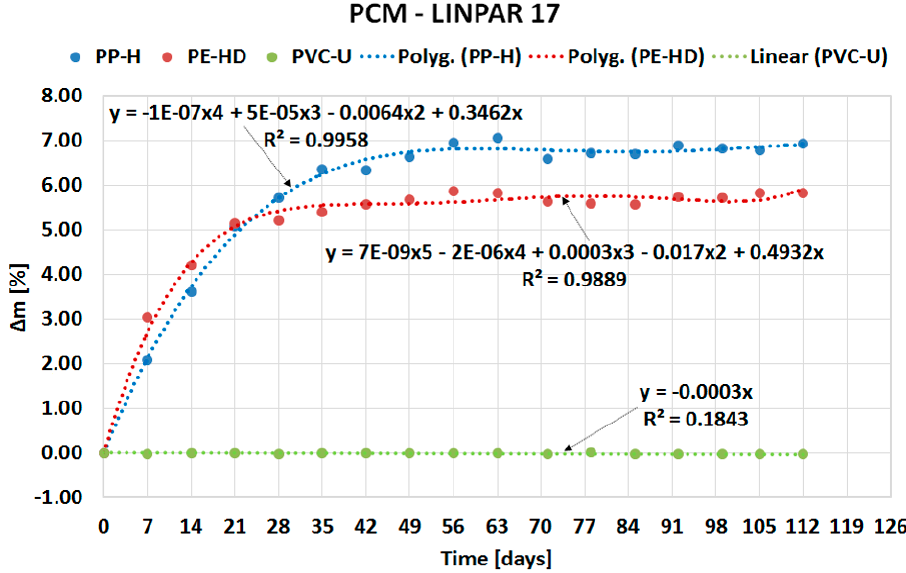
Figure 2. Dependence of mass change of tested plastics on duration of the experiment for Linpar 17.